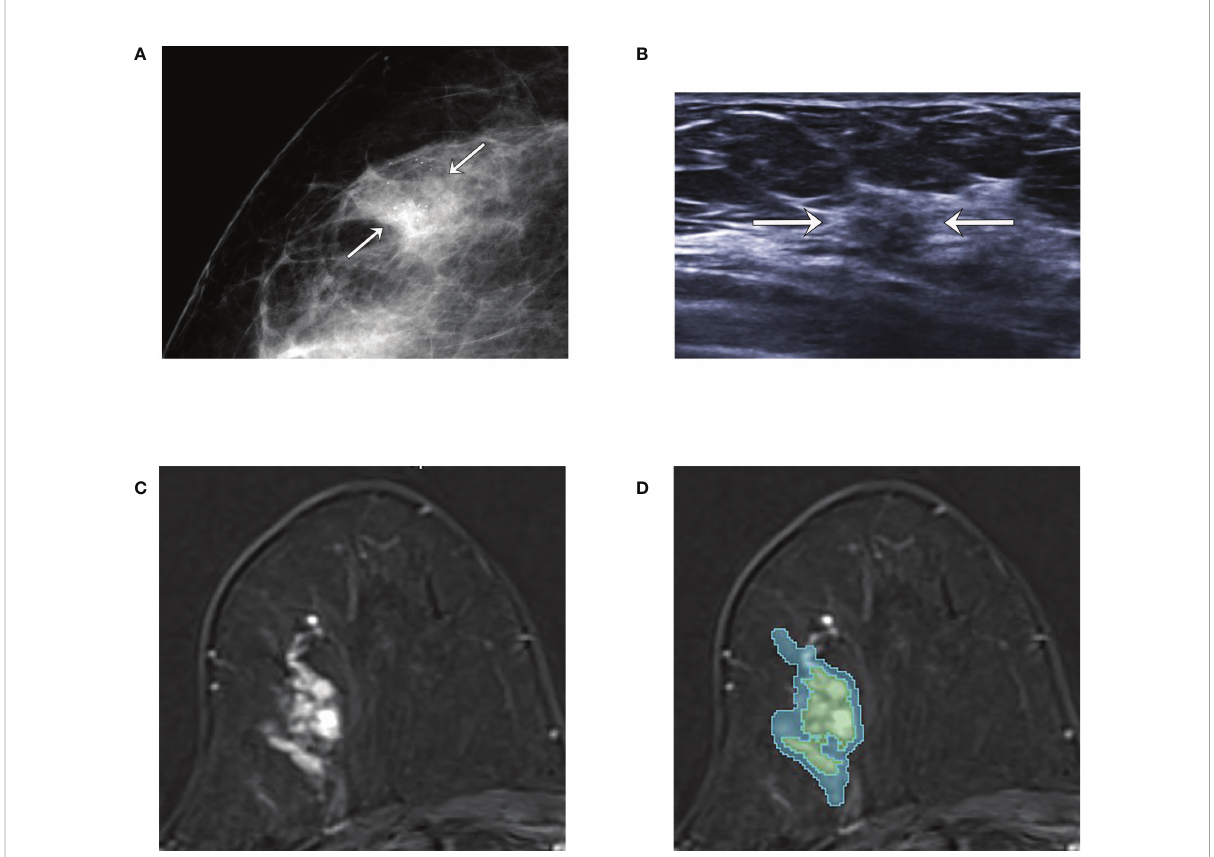
FIGURE 3 An example of tumor segmentation in a 66-year-old woman who complained of incidentally detected microcalci fi cations in the screening mammogram, which was pathologically con fi rmed as pure ductal carcinoma in situ (DCIS) after surgical excision. (A) Mammography shows focal asymmetry with grouped microcalci fi cations seen in the right outer breast (arrows). (B) Ultrasound image shows the subtle non-mass lesion with microcalci fi cations (arrows). (C) Axial fi rst postcontrast T1-weighted image with subtraction shows about 3.1 cm extent of clumped non-mass enhancement in right upper outer breast. (D) The green and blue shadings represent the intratumor and peritumor ROIs, respectively, which are created by 3D